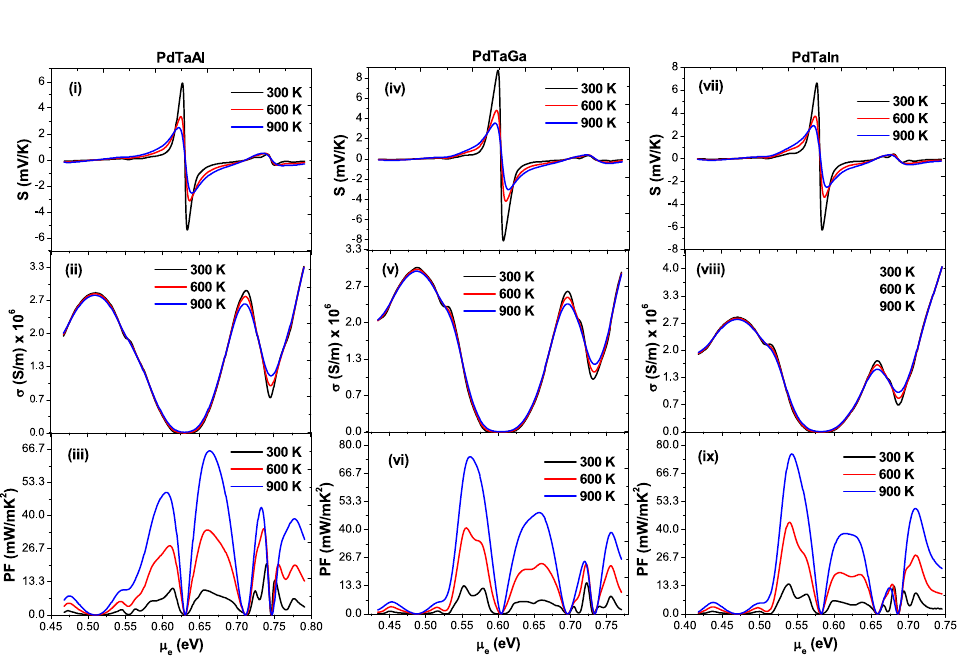
Figure 5. Transport coefficients of PdTaX(X = Al, Ga, In) alloys as a function of chemical potential: ( i , iv , vii ) Seebeck coefficient, ( iii , v , viii ) Electrical conductivity and ( iii , vi , ix )